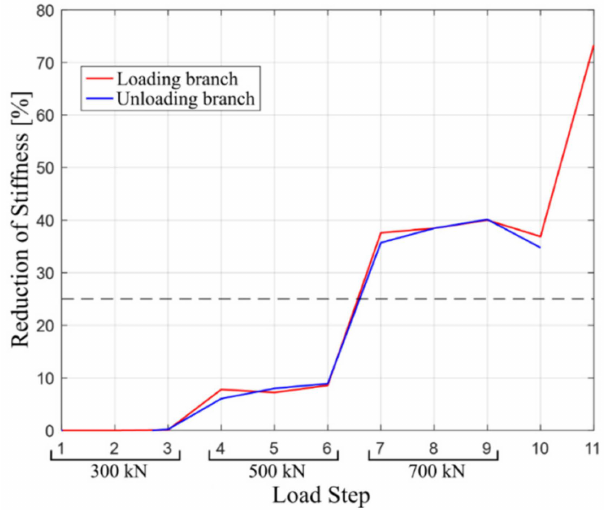
Figure 12. Reduction of stiffness loading and unloading branches per load